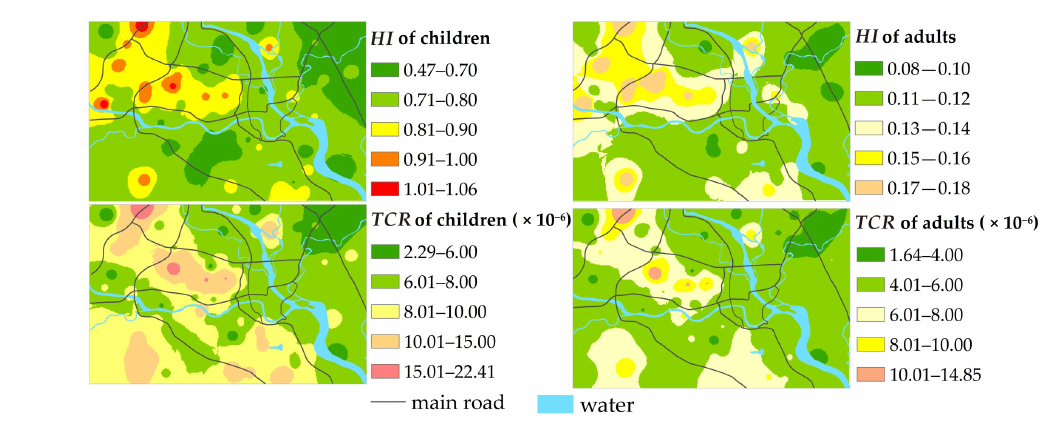
Figure 6. HI and TCR for both children and